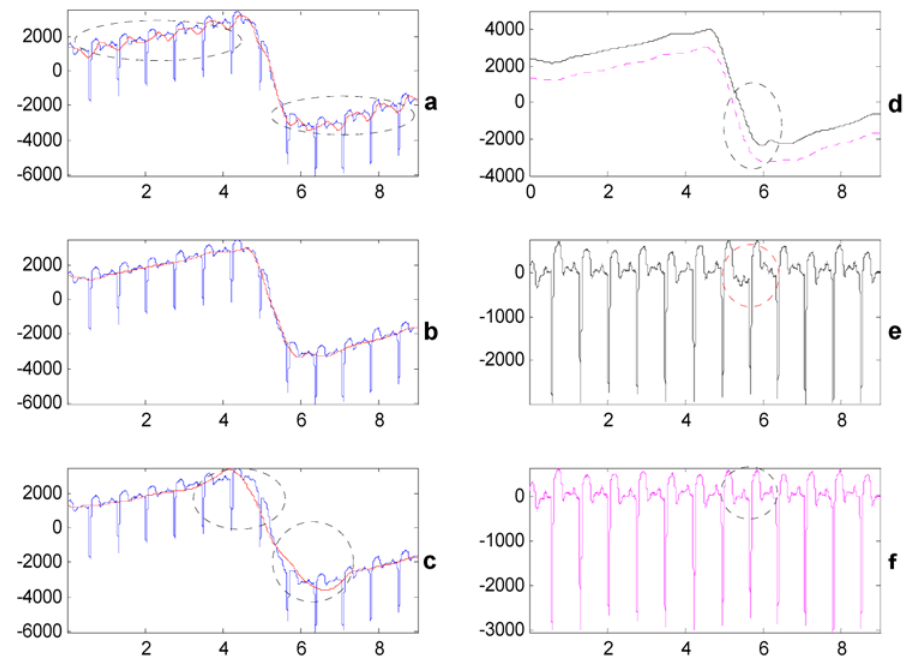
Figure 6. Comparison between the proposed method and the WT-based method (PTB record s0098lrem, lead V2, 00:10–00:19). ( a – c ) The blue waveform is BW contaminated ECG, while the red